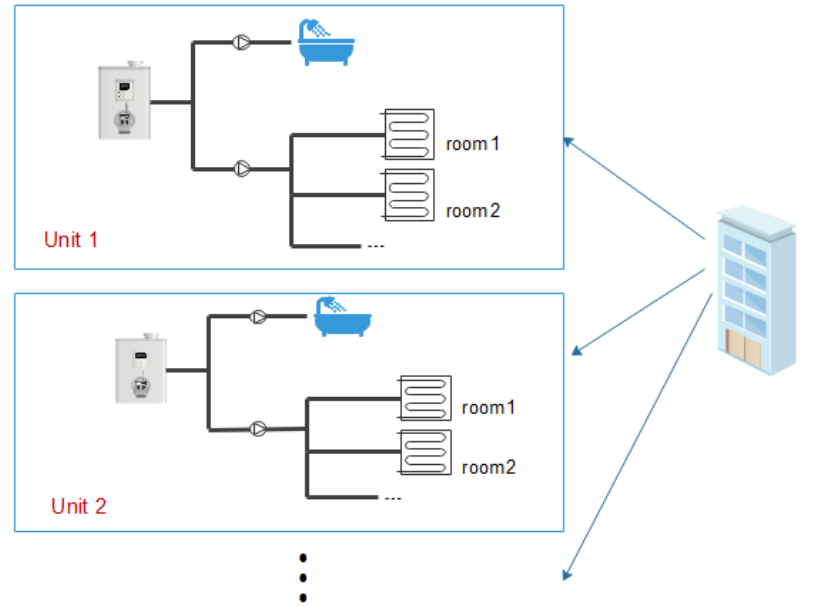
Figure 10. Simple diagram of the individual heating system in IHS-G Scenario.